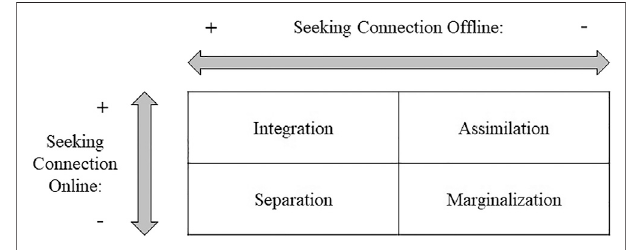
FIGURE 1 | Digital Acculturation Model and